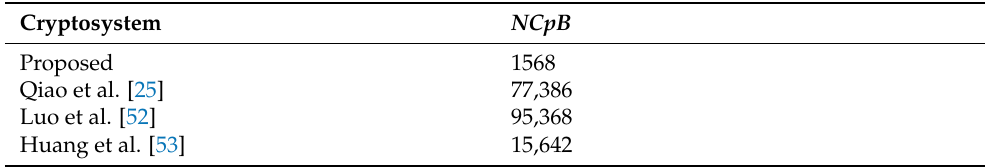
Table 13. Comparison of NCpBs from different encryption schemes. Cryptosystem NCpB Proposed